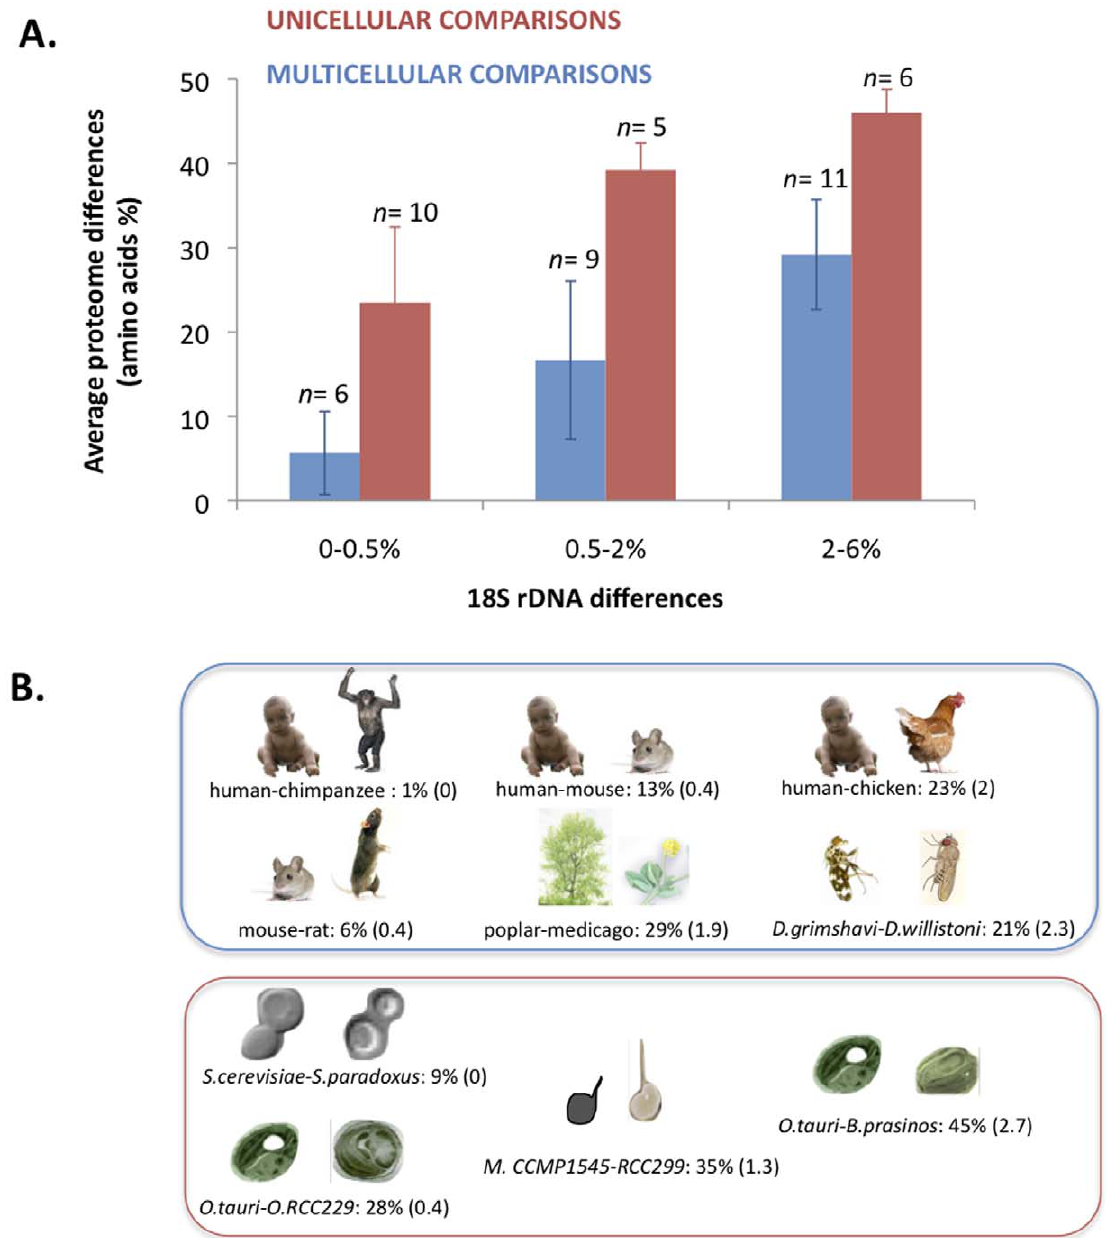
Figure 1. 18S rDNA versus proteome divergence in unicellular and multicellular lineages. A. Average proteome (amino-acid) and 18S rDNA differences (%) for 21 unicellular and 26 multicellular pairwise comparisons. The first class of 18S rDNA sequence differences limit, 0.5%, is the smallest threshold used to delineate Operational Taxonomic Units (OTU) in planktonic eukaryotes [26]. B. Selected examples of pairwise comparisons in each 18S rDNA divergence class: percent of amino-acid divergence (percent of 18S rDNA differences).